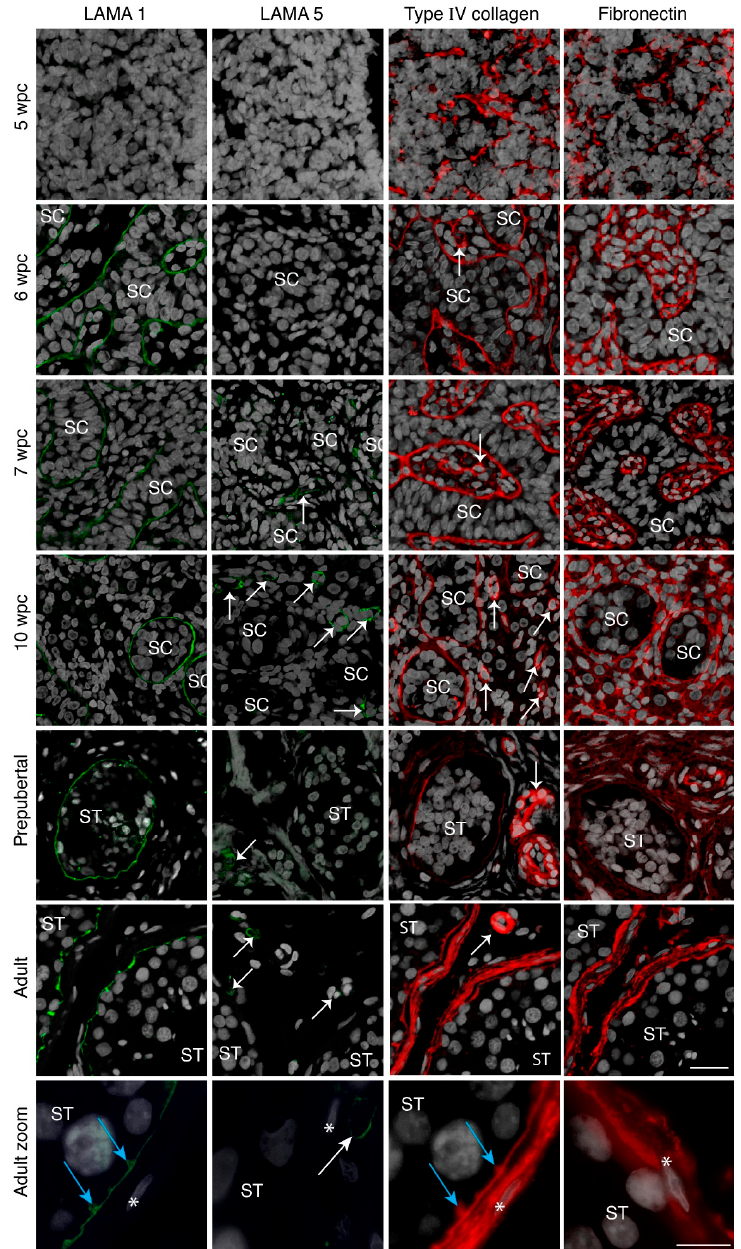
Figure 1. Basement membrane expression of prenatal gonadal and postnatal testicular tissue. Laminin alpha 1 (LAMA 1) (green staining) expression is shown from 6 wpc onwards in the seminiferous basement membrane (BM), while LAMA 5 (green staining) can be observed only in the vasculature from 7 wpc onwards. Type IV collagen (red staining) and fibronectin (red staining) expression is noted from 5 wpc as a net-like structure in the seminiferous BM and also the interstitium in prenatal samples from 6 wpc onwards. Prenatal sample n = 27. Prepubertal testicular samples show LAMA 1 expression in the seminiferous BM while LAMA 5 can be observed in the vasculature. Type IV collagen and fibronectin is noted in the seminiferous BM, the vasculature and the interstitium. Prepubertal sample n = 16. Adult testicular samples show specialization with LAMA 1 expression in the innermost BM, type IV collagen expression throughout the entire BM, and fibronectin expression in the peritubular BM layer. Adult sample n = 3. Counterstain with DAPI (grey staining). SC depicts the seminiferous cord, ST depicts seminiferous tubules, white arrows indicate blood vessels, blue arrows show innermost BM protrusions between tubular cells, * indicate peritubular cells, scale bar: 25 µ m, zoom scale bar: 10 µ